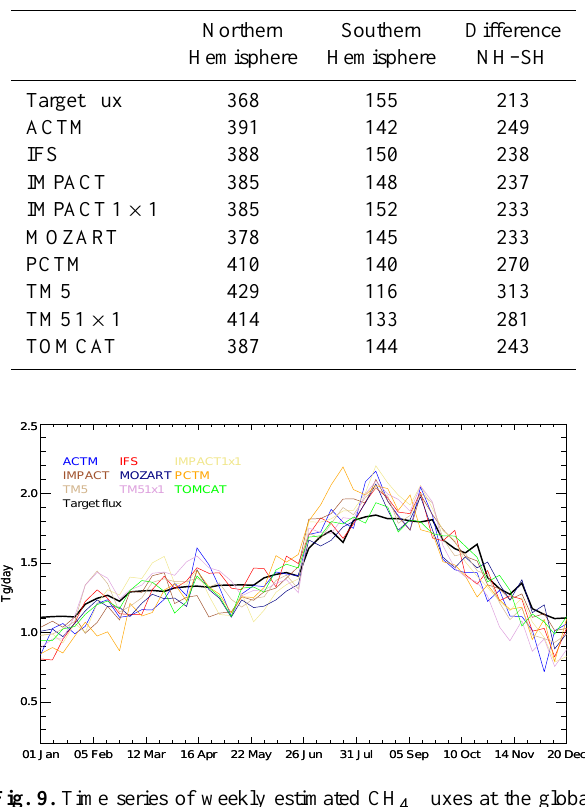
Fig. 9. Time series of weekly estimated CH 4 fluxes at the global scale for every TransCom model. The black line represents the time series of the target